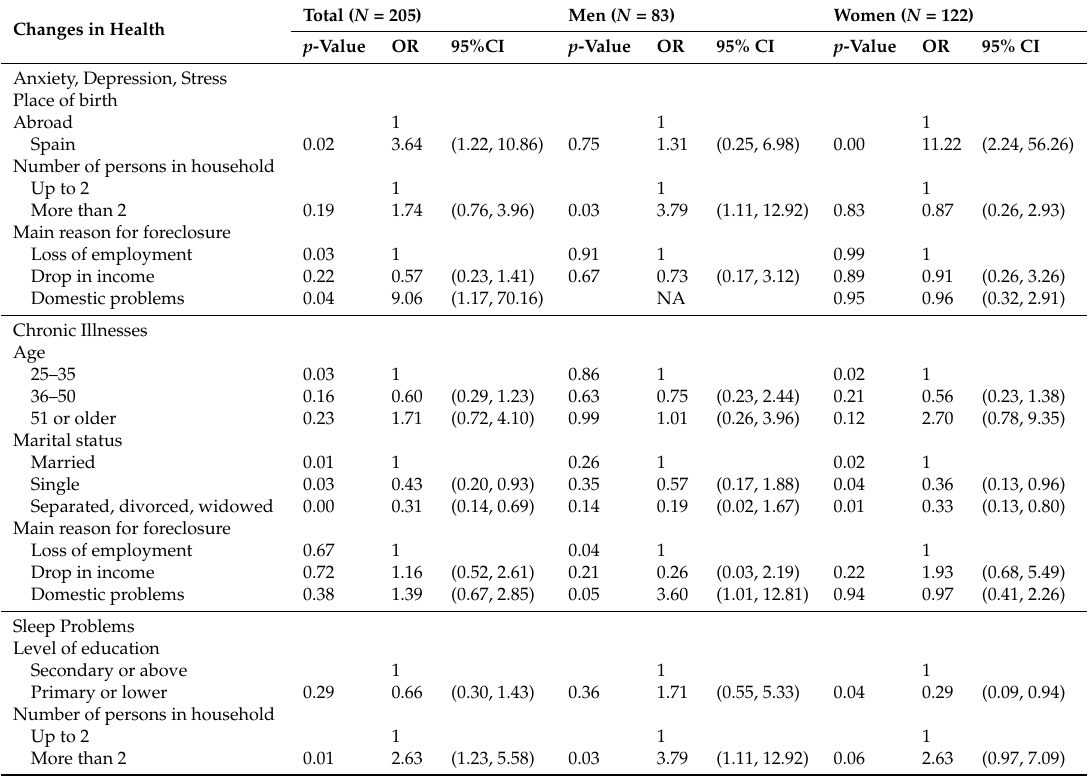
Table 3. Risk factors associated with self-perceived changes in health (Univariate Regression Models).